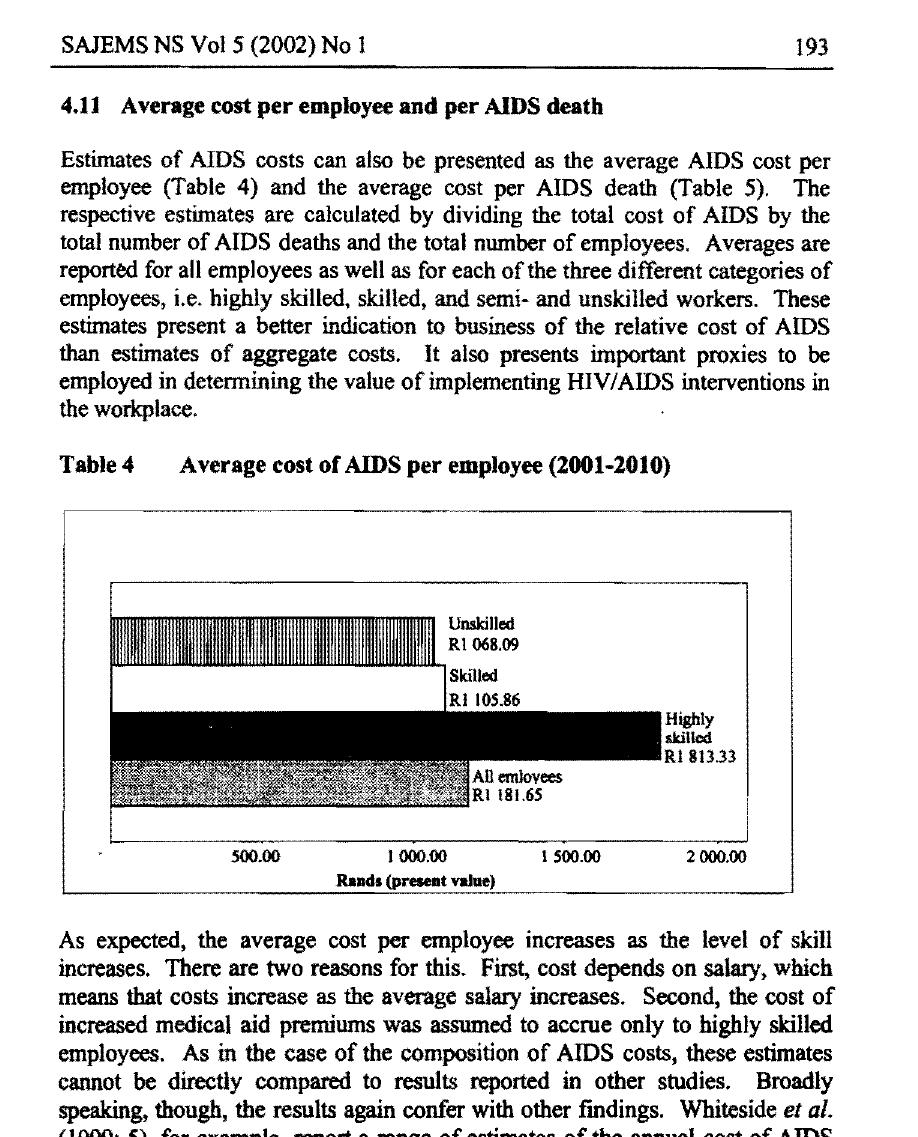
Average cost of AIDS per employee